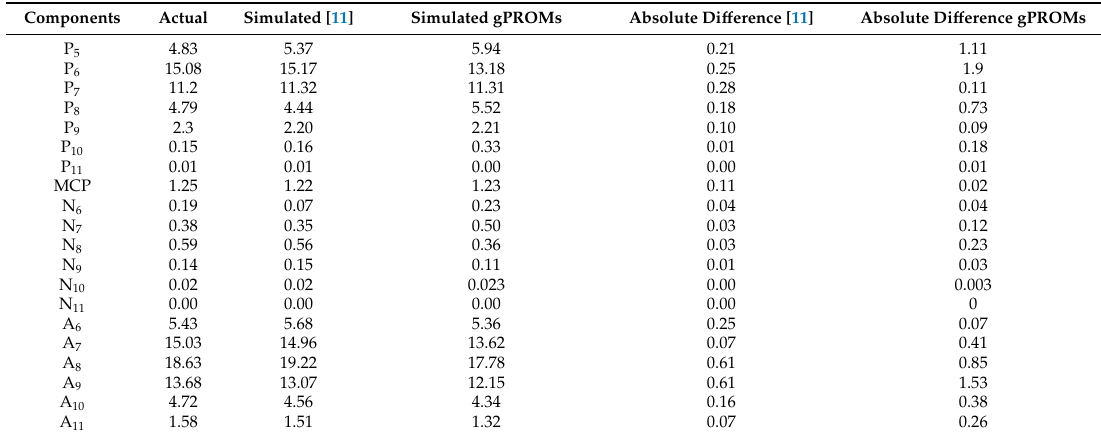
Table 6. Comparison between results from MATLAB [11] and gPROMs.